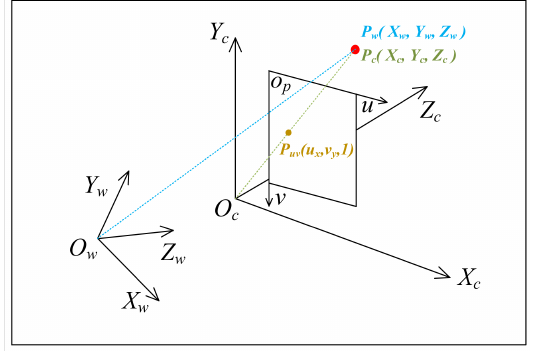
Figure 7. Coordinate systems.